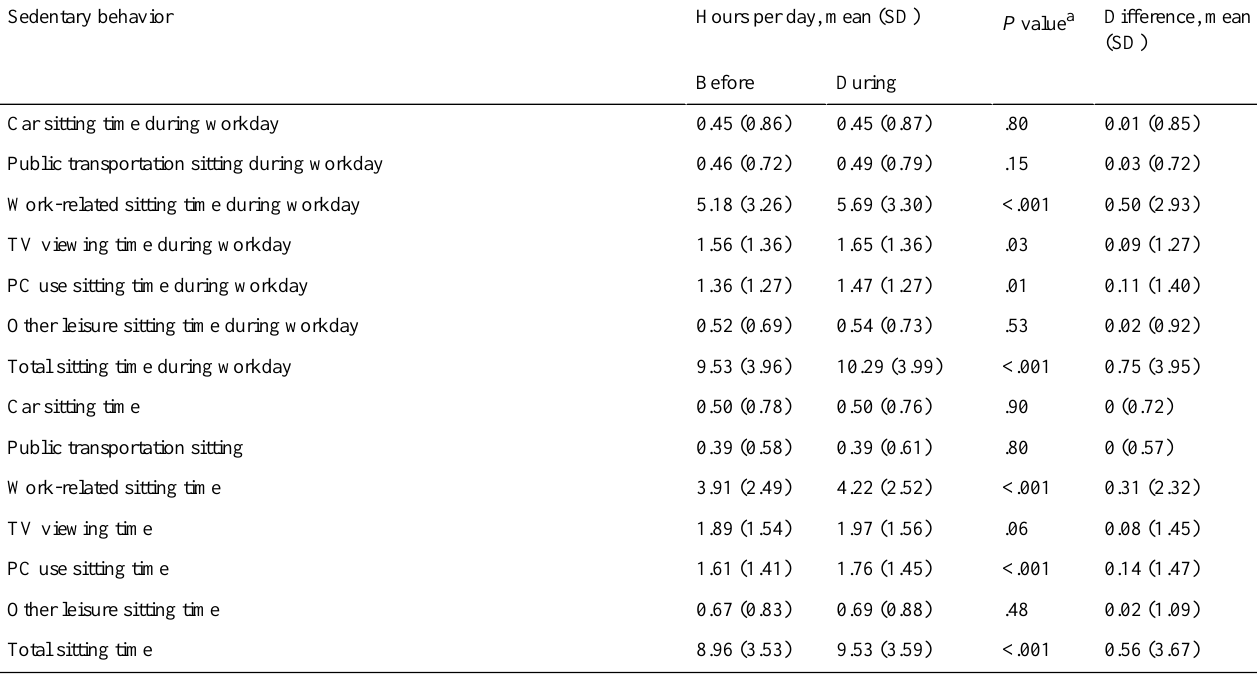
Table 2. Workers’domain-specific sedentary behaviors before (February 2019) and during (July 2020) the COVID-19 outbreak in Japan (n=1086).